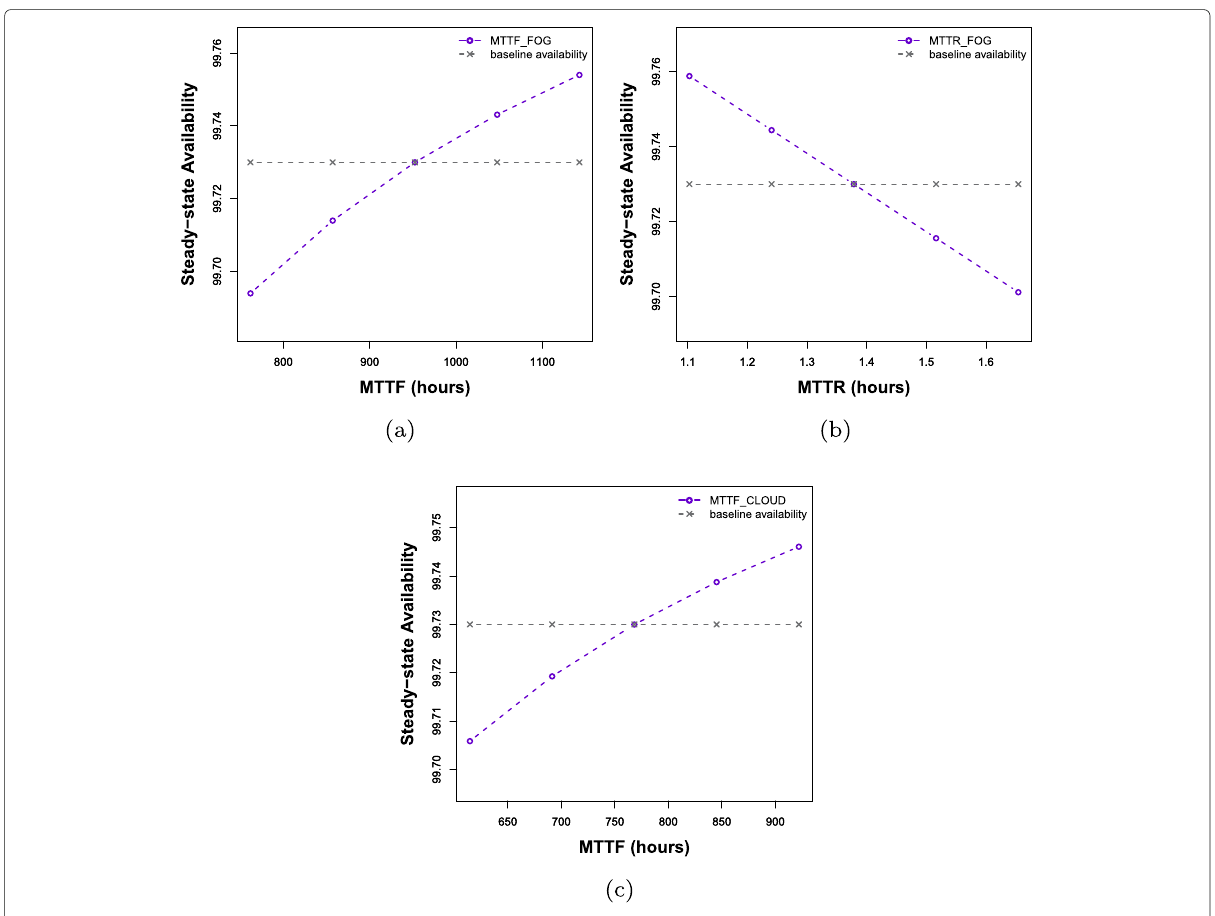
Fig. 14 Availability results for scenario 1 varying a the fog device MTTF, b the fog device MTTR and c , the cloud